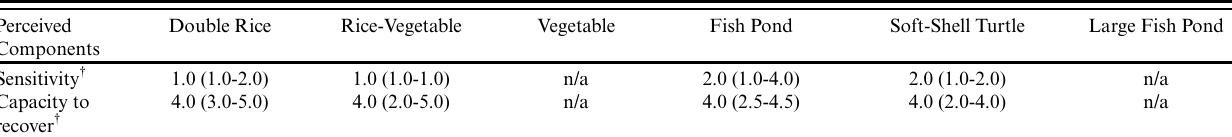
Table 5 . Median values of perceived sensitivity of agricultural systems to increased salinity intrusion and recovery capacity for the interviewed farmers in the Red River Delta (interquartile ranges in parentheses).